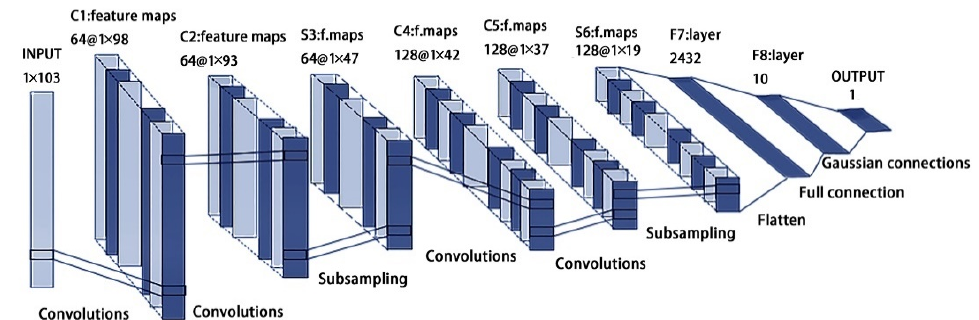
Figure 6. Improved LeNet-7 network model structure.